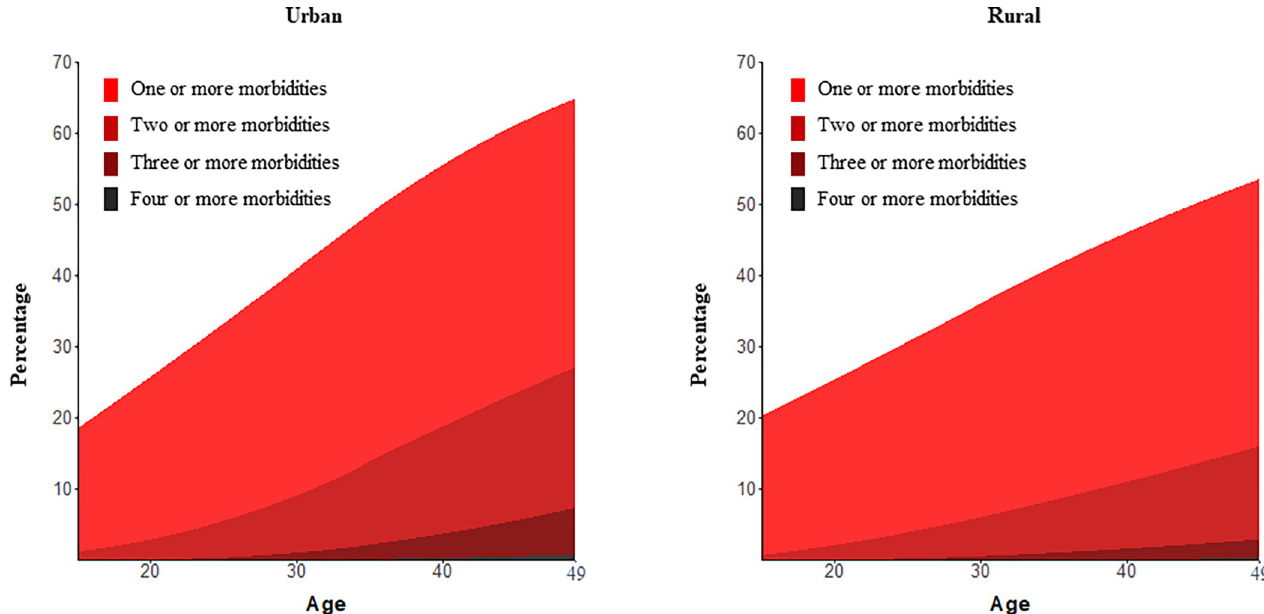
Fig 1. Prevalence of morbidity and multimorbidity by age and urbanicity in India 1 . 1 The prevalence of each number of morbidities (with 95% confidence intervals) is shown in S3 Table .